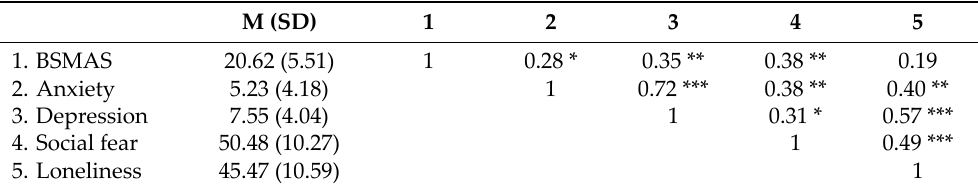
Table 2. Descriptive data and inter‑correlations between variables ( n =